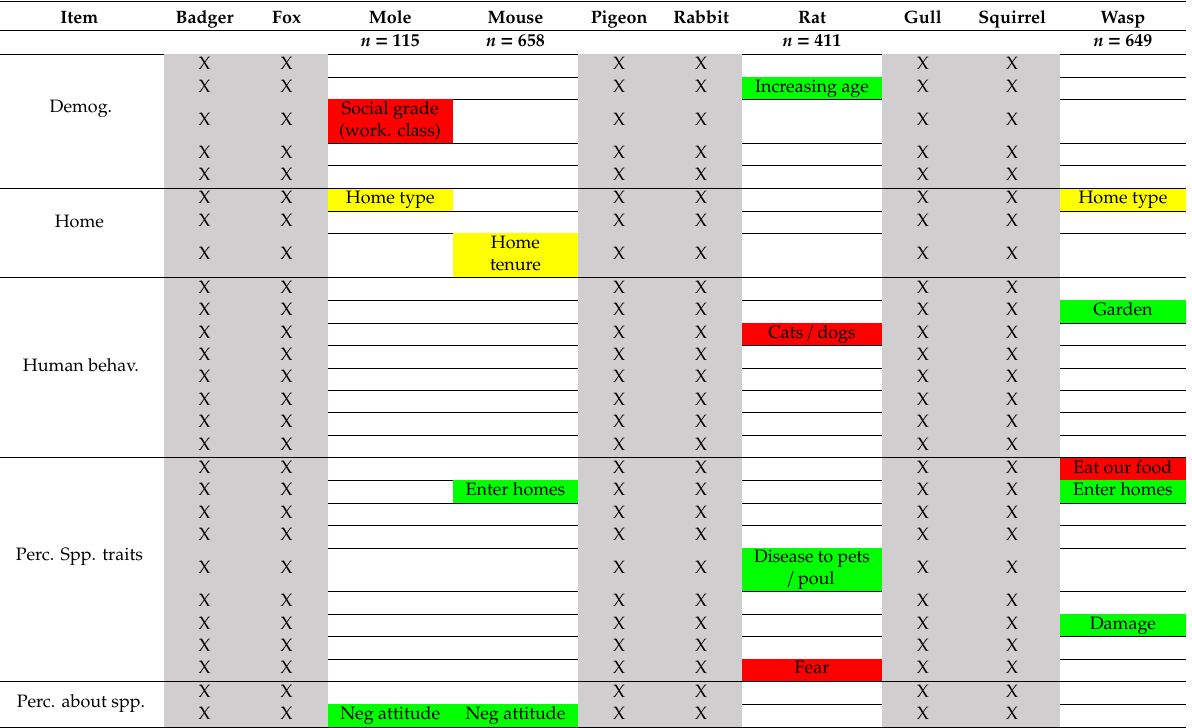
Table 8. Factors associated with people’s past control of each of four species when they had experienced problems personally with that species. Factors are grouped under: Demog. = ‘Demography’, Home = ‘Home’, Human behav. = ‘Human behaviour’, Perc. spp. traits = ‘Perceived species traits’, and Perc. about spp. = ‘Perceptions about species’. Factors shown in red were associated with a lower likelihood of having used control, those shown in green were associated with a greater likelihood, and those shown in yellow were associated with a more complex e ff ect. See list of abbreviations for factors in Supplementary Materials Table